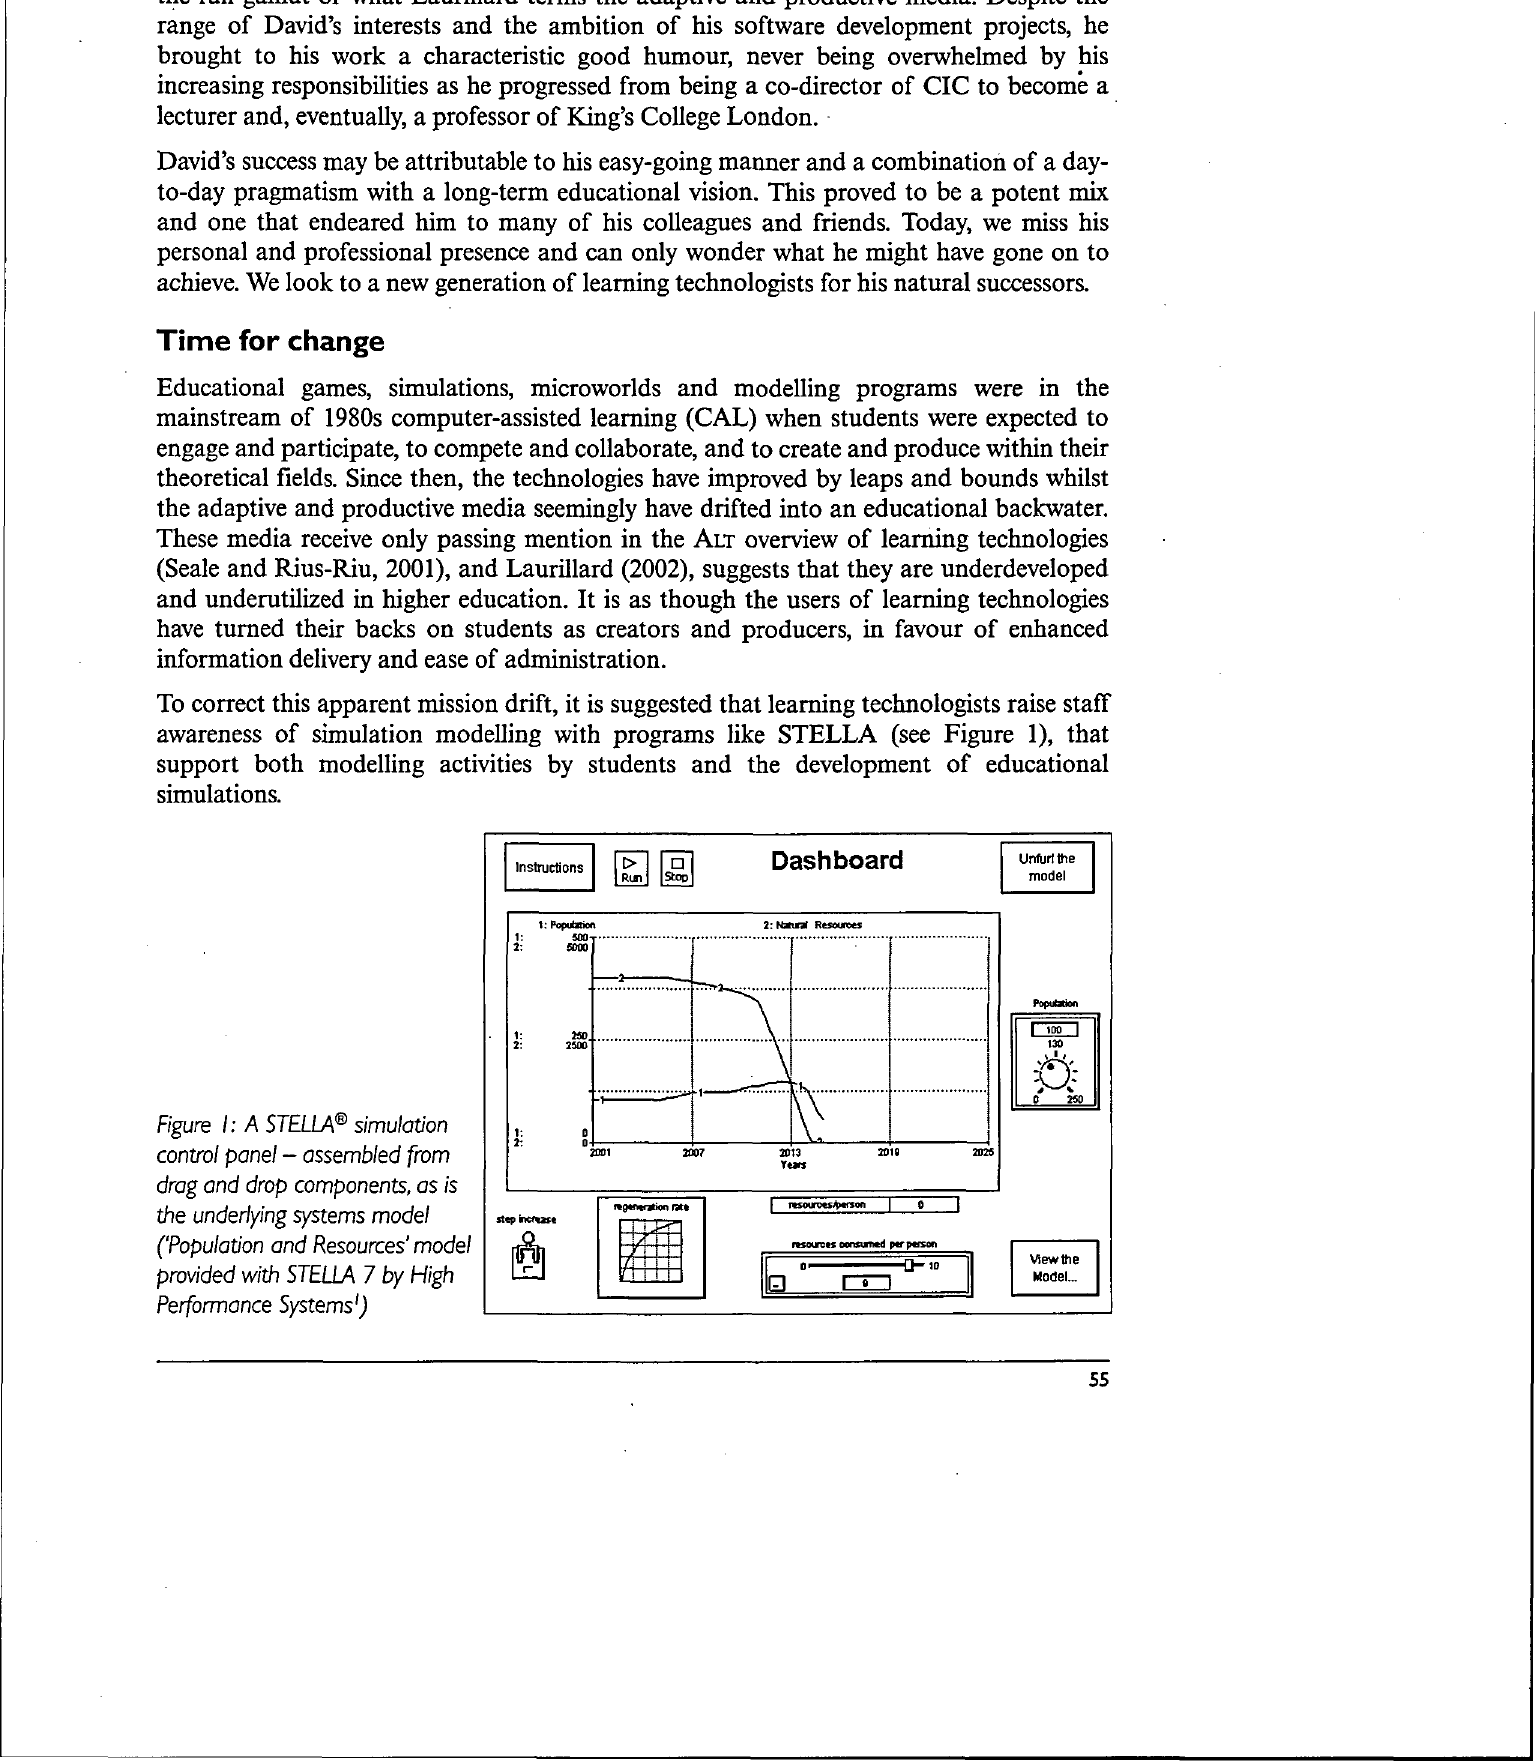
Figure I: A STELLA® simulation control panel - assembled from drag and drop components, as is the underlying systems model ('Population and Resources' model provided with STELLA 7 by High Performance